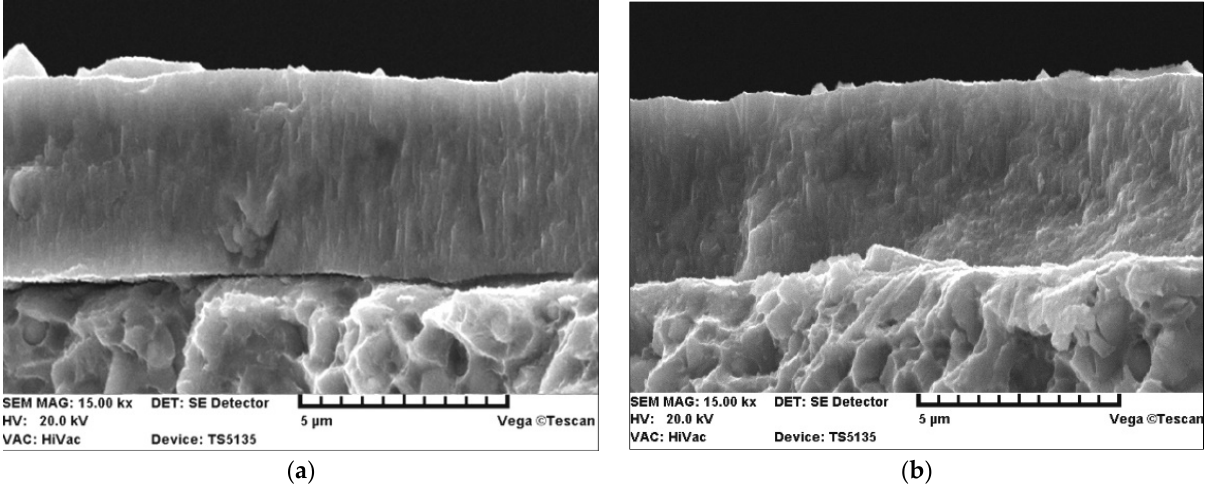
Figure 10. SE images of the fracture of the TiN coating ( a ) before and ( b ) after laser heating with 40% of the maximum laser power.